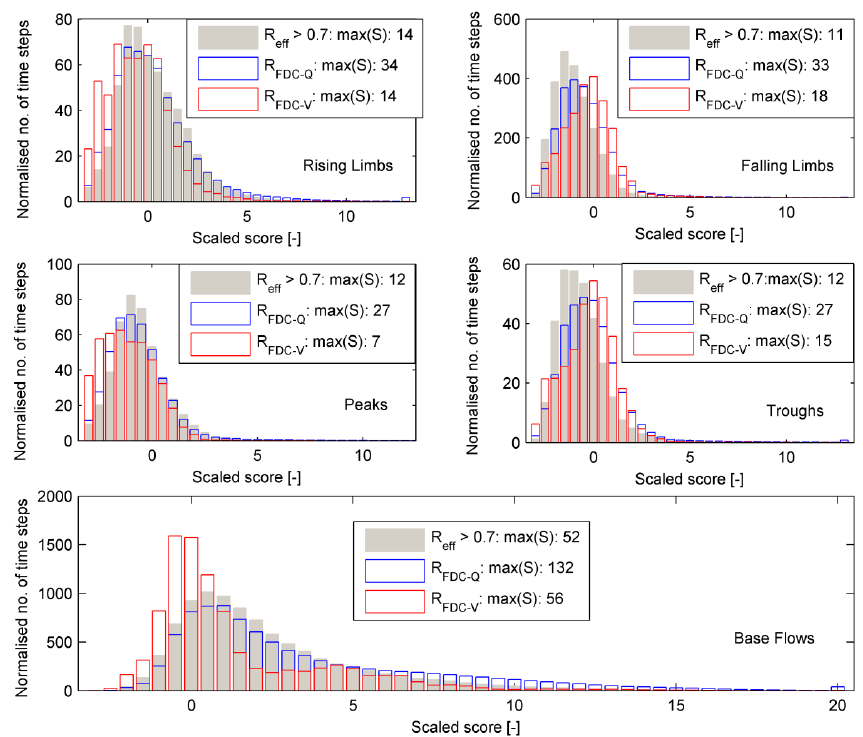
Fig. 15. Scaled scores to limits of acceptability for different parts of the hydrograph at Brue for calibration in 1997–1998 using Dynamic TOPMODEL. For each performance measure the histograms were normalised by the number of behavioural simulations, so the y-axis represents the normalised number of time steps. The upper range of the histogram x-axis was limited to improve the visibility of the lower range, the maximum scaled scores, max( S ), for each criterion are given in the legends and all scaled scores larger or equal to the last bin are plotted in the last bin.